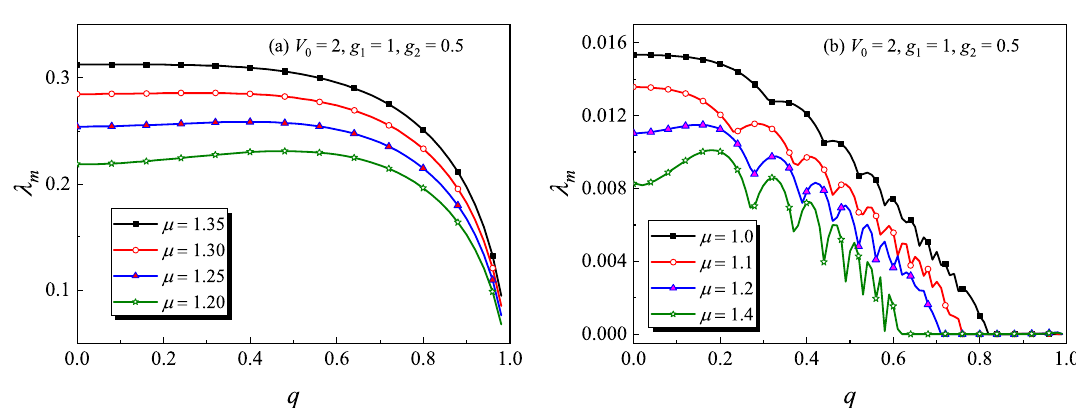
Figure 11. Maximum growth rate of perturbation (cid:31) m for dark solitons versus the modulus of external potential q under different chemical potential µ . The profiles of dark solitons are similar as those shown in Fig. 9a or d. ( a ) bubble-like soliton ( b ) kink